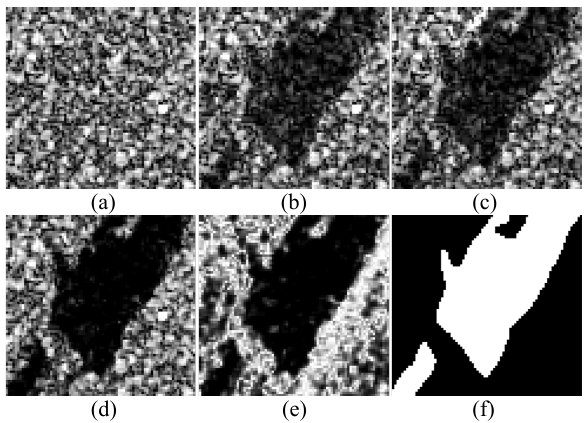
Figure 5. The close-up view of the red rectangle in Figure 4 γ , (c) ˆ γ , and (d) Proposed ˆ γ , (b) ˆ with (a) ˆ α m c ratio operator, and (f) corresponding ground